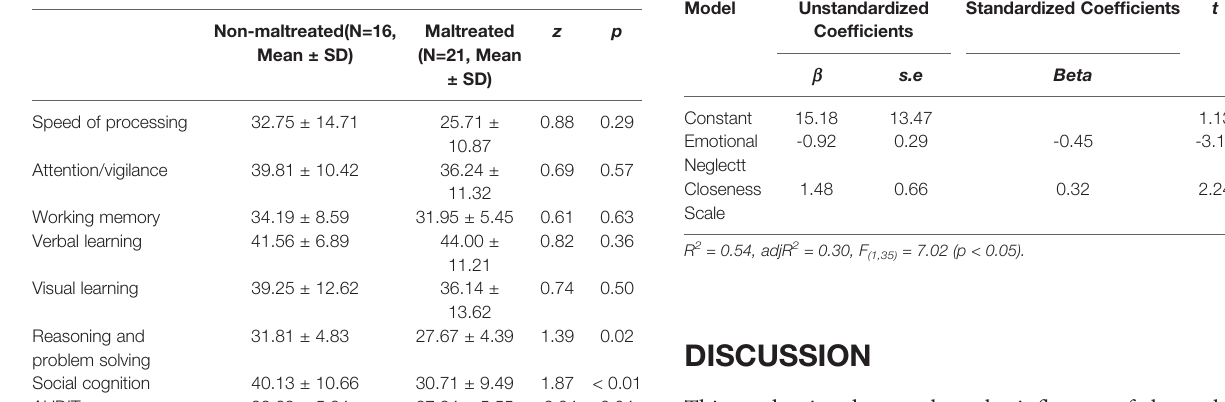
TABLE 2 | Description of cognitive function measured in patients with alcohol use disorders.